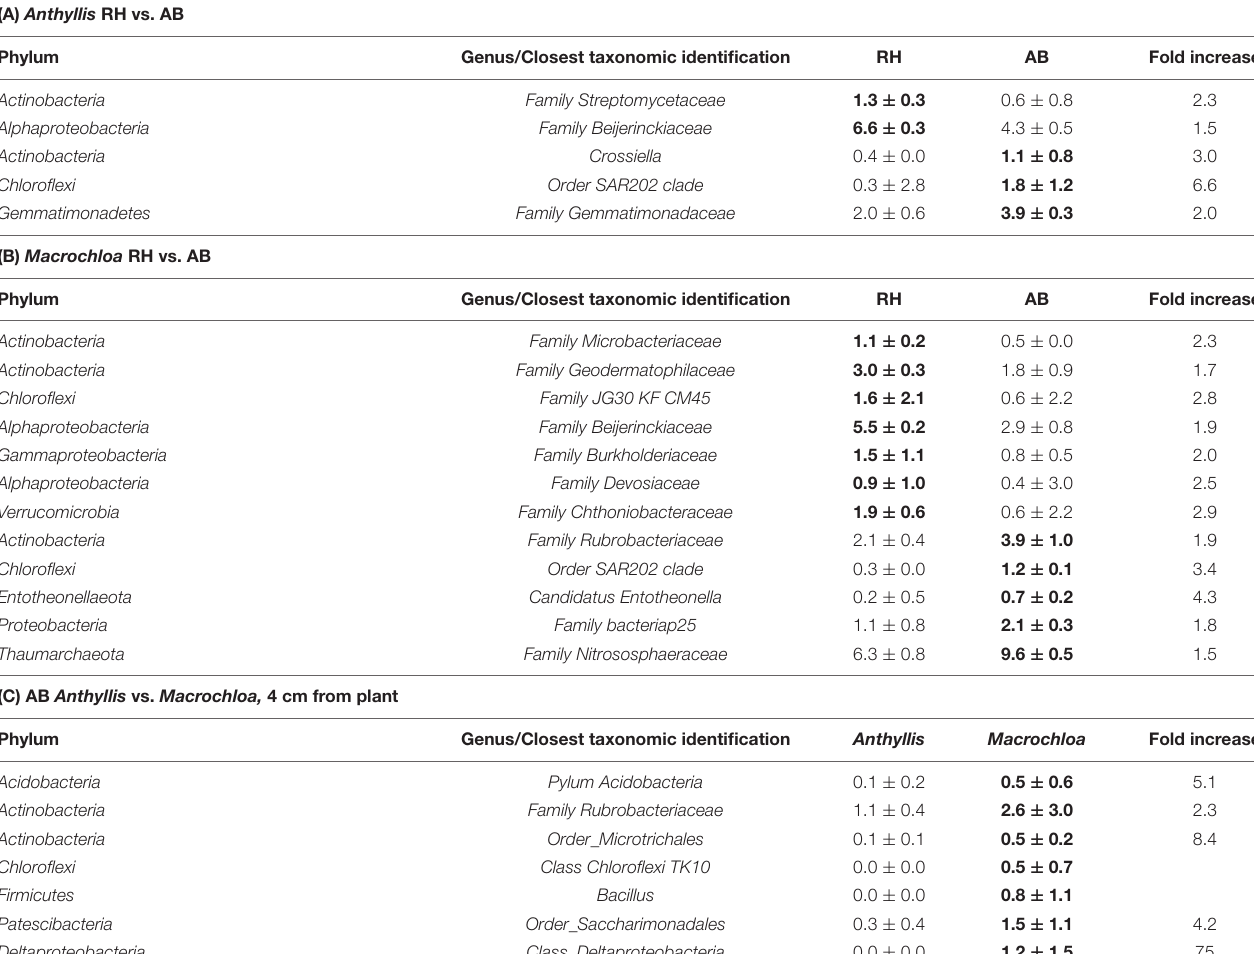
TABLE 2 | Relative abundances (%) ± standard deviation of prokaryotic genera ( > 0.5%) that significantly differed between the Rambla Honda (RH) and Alboloduy (AB) sites for Anthyllis cytisoides (A) and Macrochloa tenacissima (B), and between Anthyllis and Macrochloa at Alboloduy (C) site at a distance of 4 cm from plant ( p < 0.05, higher relative abundances shown by bold